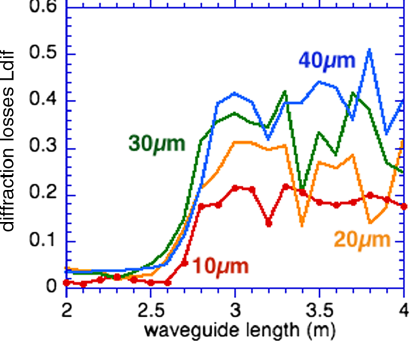
versus waveguide length d dif